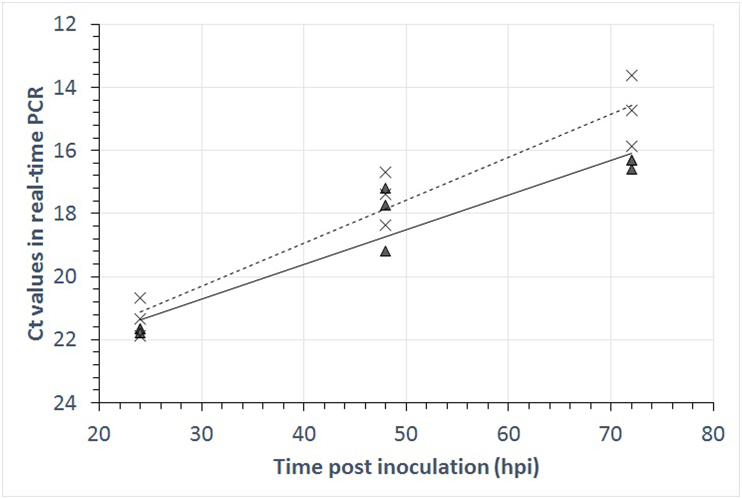
Growth of Besnoitia besnoiti Bb-EvoraCl2 (triangles) and Besnoitia tarandi Bt-CA-Quebec1 (crosses) as assessed by real-time PCR on in-vitro cultivated MARC-145 cells 24, 48 or 72 h p.i. Linear regression revealed that B. tarandi Bt-CA-Quebec1 grew faster than B. besnoiti BbEvoraCl2.